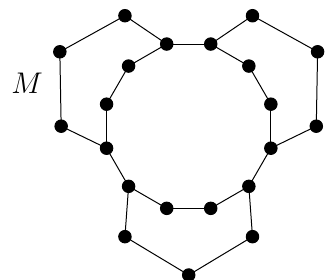
Figure 2: The smallest 2-connected graph with proper connection number 3